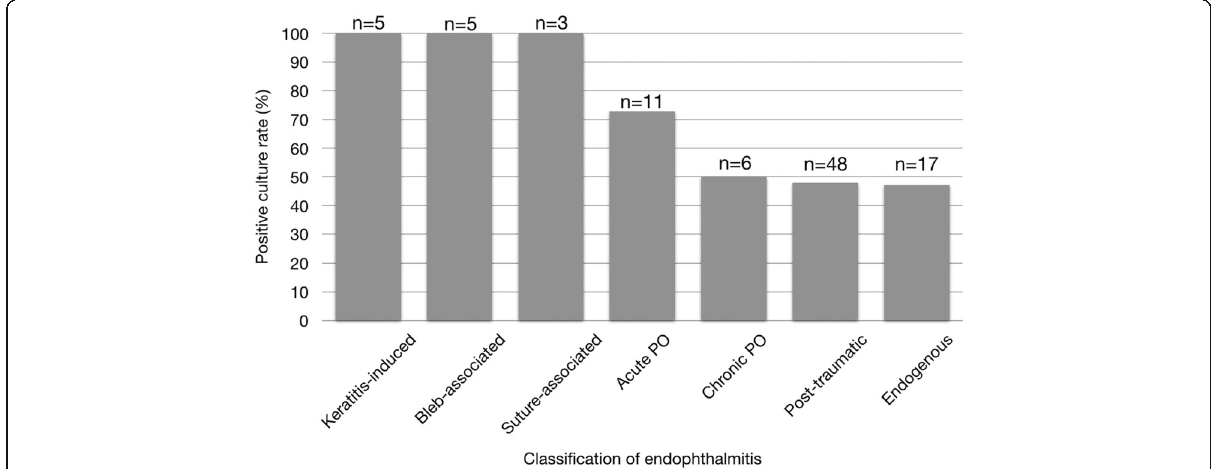
Fig. 3 Positive rates of microbial cultures among the different groups ( n = 95). Albeit fewer, keratitis-induced, bleb-associated, and suture- associated cases had high culture positivity rates, while only around half of chronic post-operative, post-traumatic, and endogenous cases yielded positive cultures. PO =